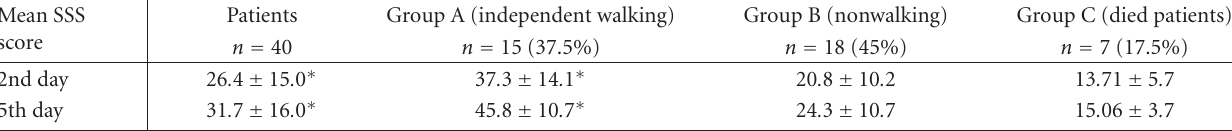
Table 1: Mean SSS scores of patients (a)